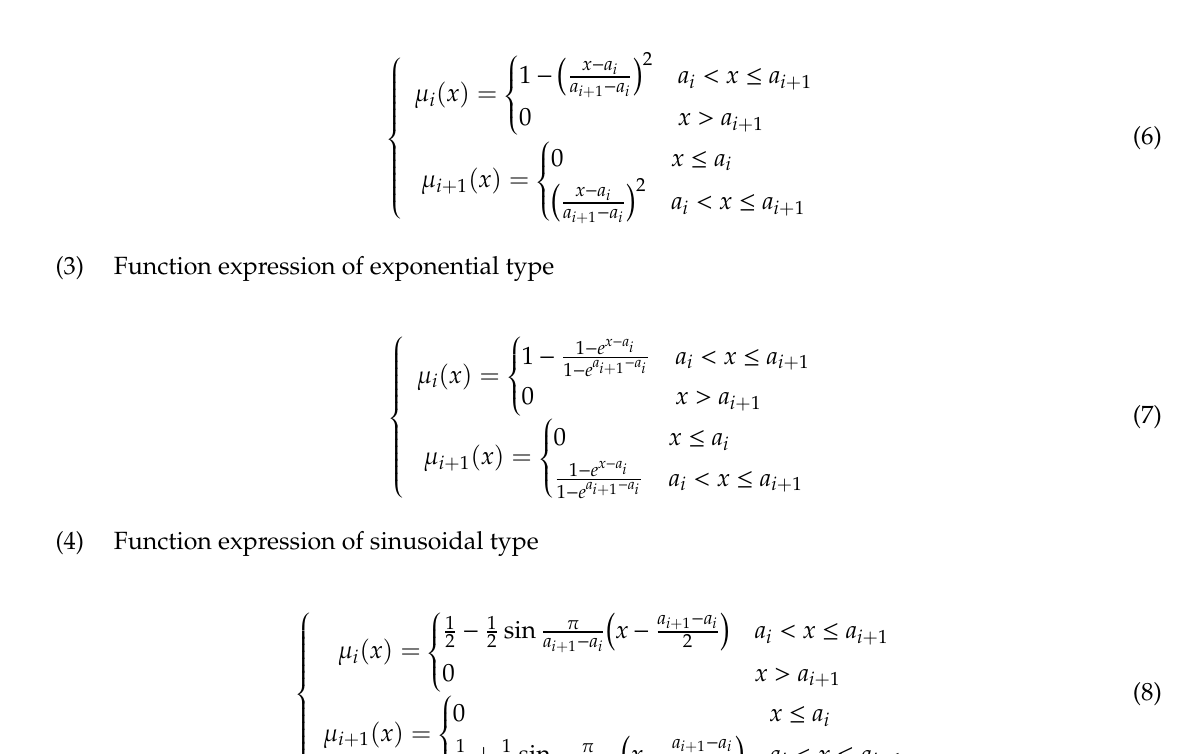
Figure 3. Exponential-type function.